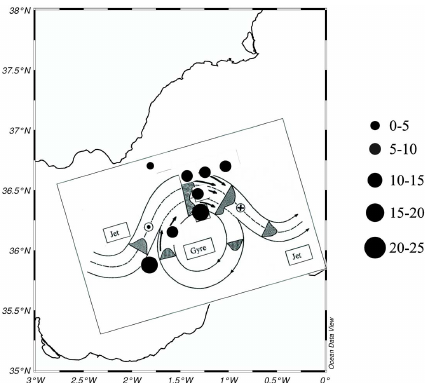
Fig. 19. Distribution of mesozooplankton biomass (dry mass in mgm − 3 ) in the 0–200m layer of the Almeria-Oran area, as affected by the hydrological features. Modified with permission from Yous- sara and Gaudy,